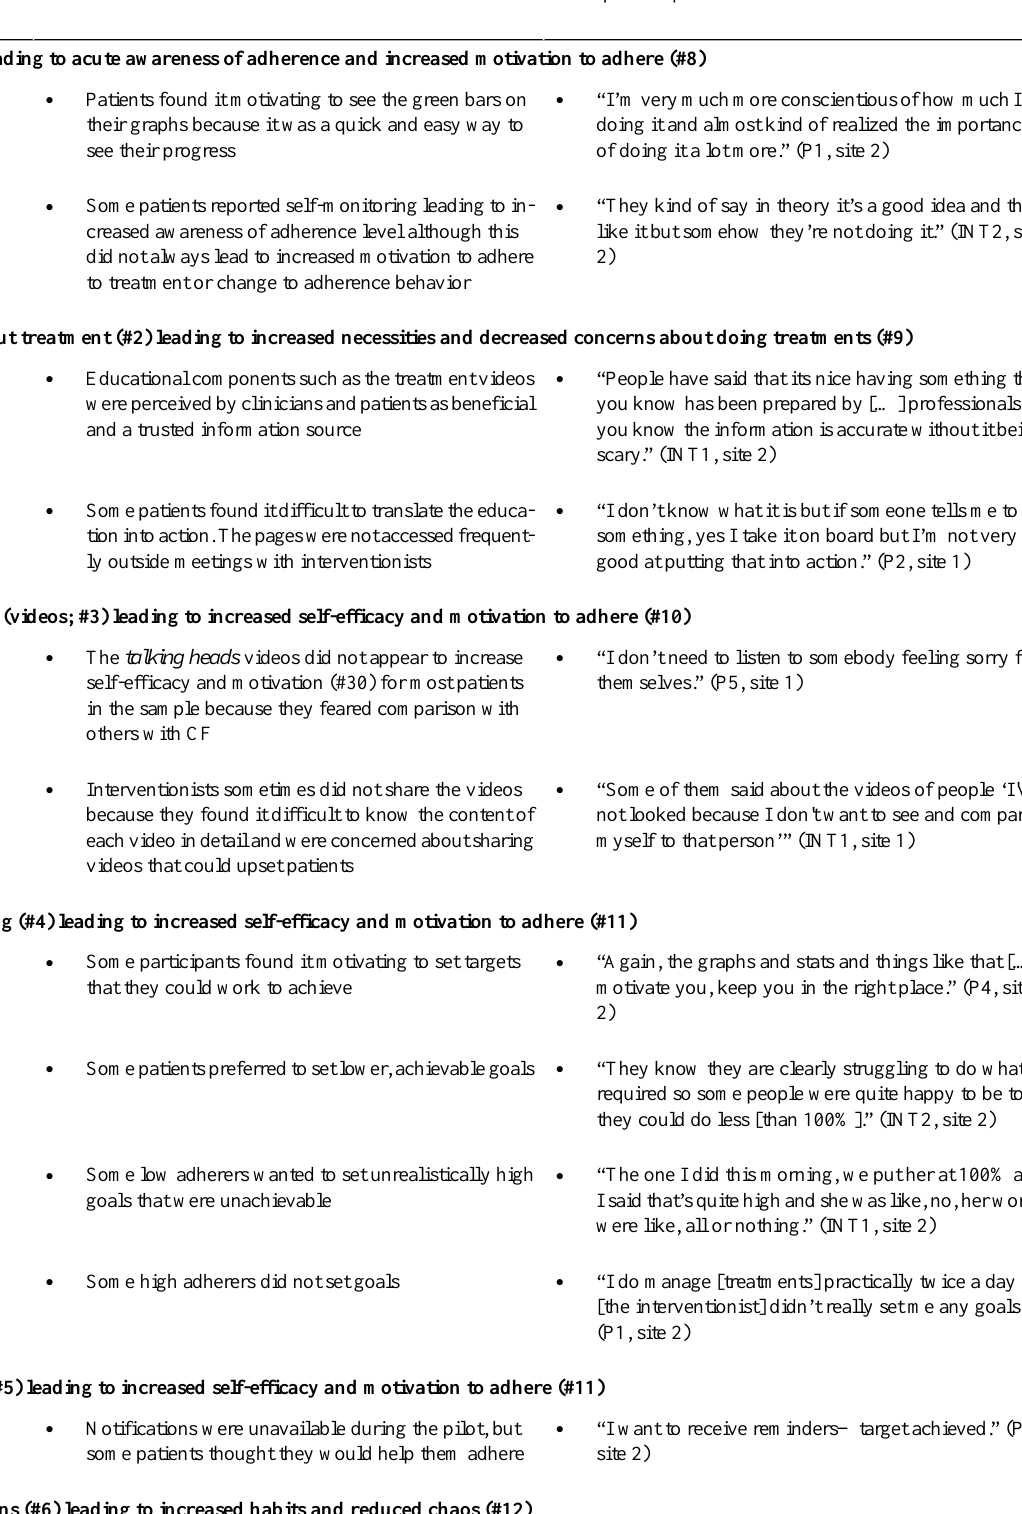
Examples of quoteEvidenceComponent and mechanism